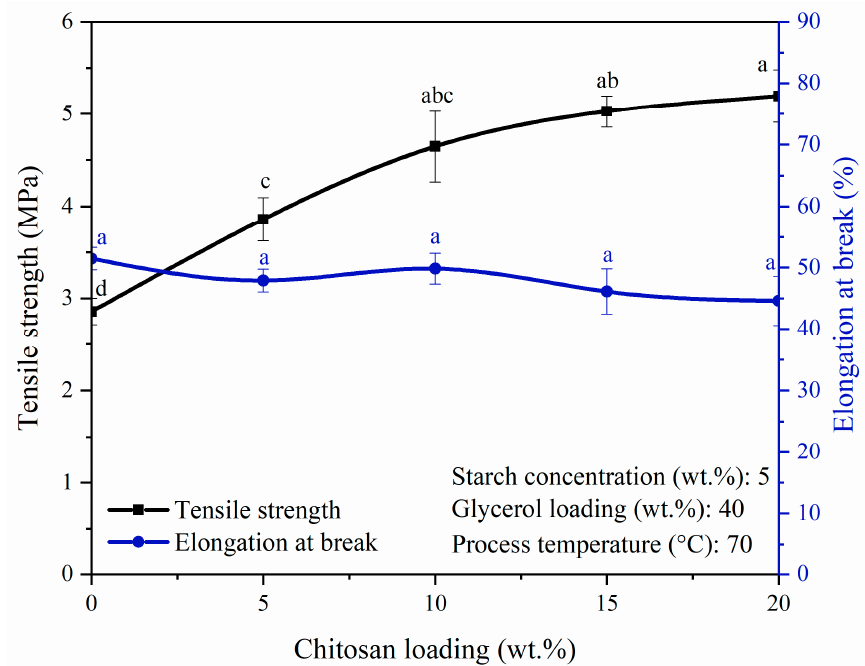
Figure 5. Tensile strength and elongation at break of bioplastic films at various chitosan loadings. Different letters indicate the values are significantly different ( p < 0.05).